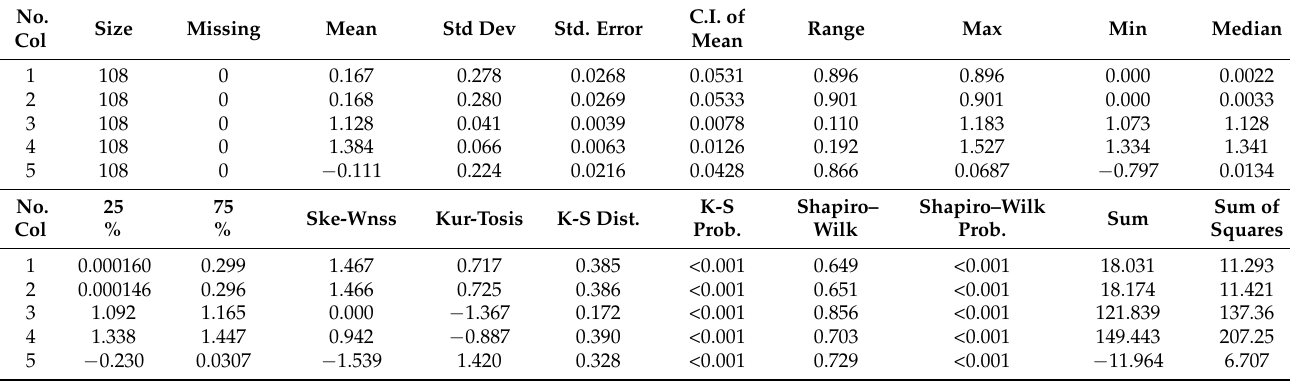
Table 3. Statistical description of the database.